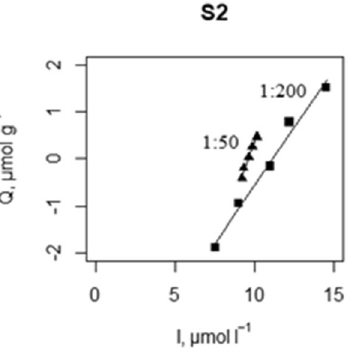
Fig. 6 Phosphorus exchange isotherms of freeze-dried sediment S2 at the P addition levels 0 − 20 µmol l −1 when using solid-to-solution ratios of 1:50 and 1:200. The comparison illustrates the impact of the differing solid-to-solution ratios on the isotherms. I = equilib- rium P concentration, Q = amount of P desorbed from or sorbed onto the